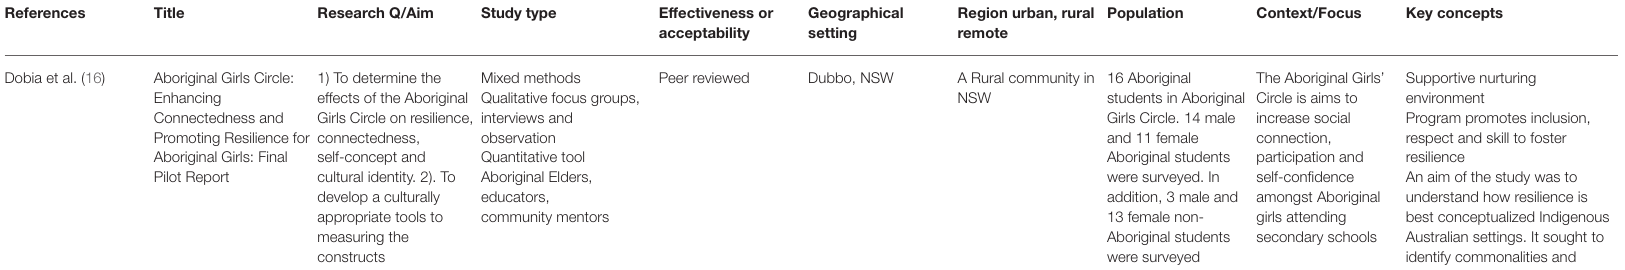
TABLE 3 | Included studies with characteristics and key